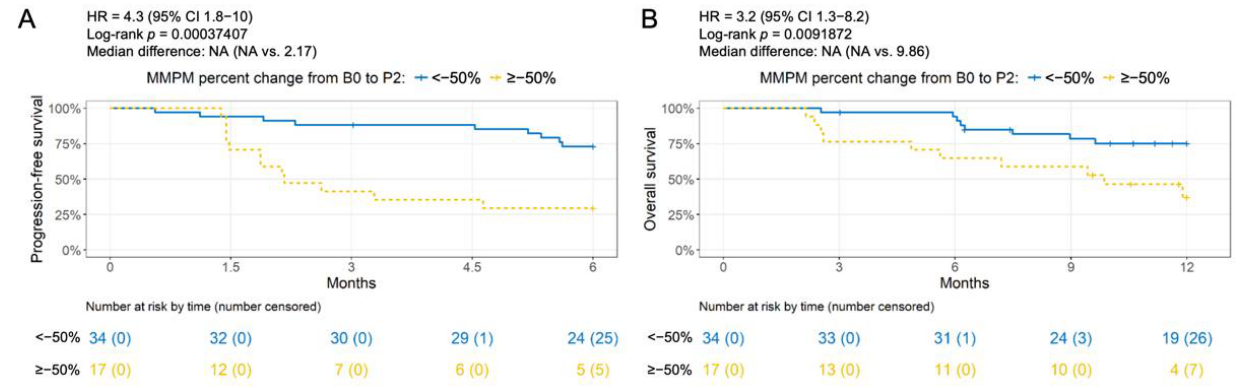
Figure 5. Association between survival and ctDNA decrease after two chemotherapy cycles. Progression-free survival ( A ) and overall survival ( B ) for >50% vs. ≤50% decrease in mean mutant molecules per milliliter (MMPM) from baseline in the first available plasma after two cycles of chemotherapy.